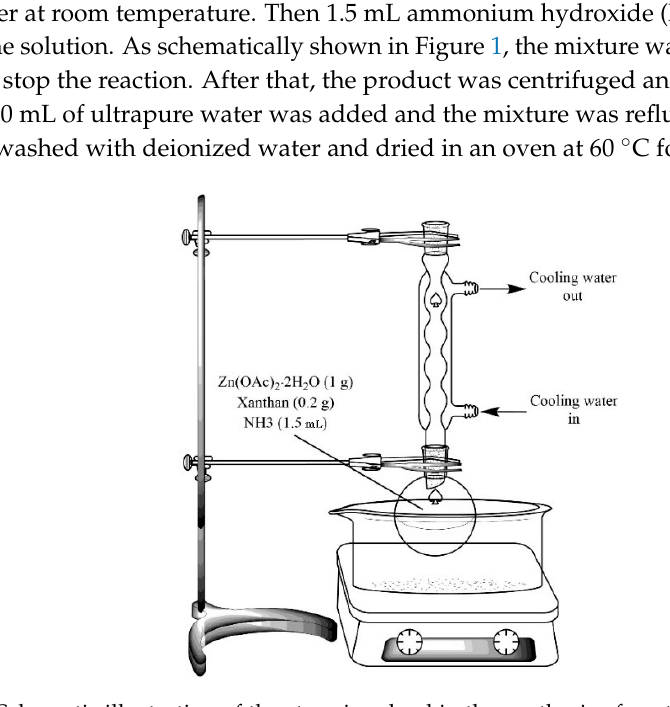
Figure 1. Schematic illustration of the steps involved in the synthesis of xanthan gum (XG)-capped zinc oxide (ZnO) microstars using an efficient hydrothermal method.